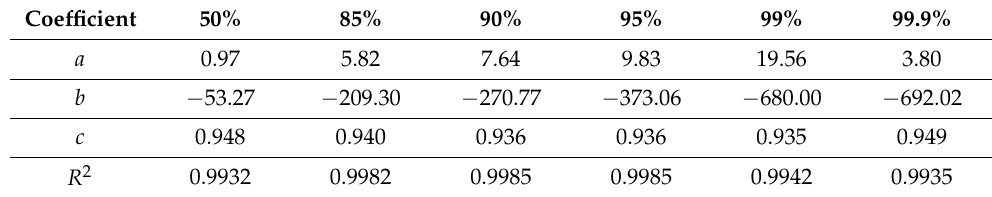
Table 5. The exponential fit result of the steering wheel speed.